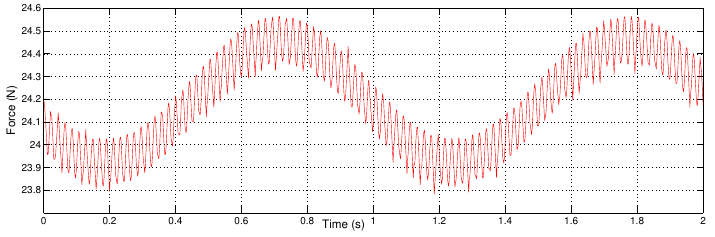
Figure 14. Cutting force along x